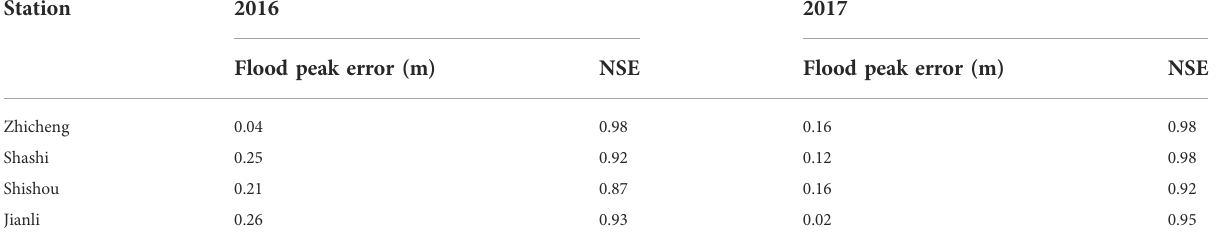
TABLE 1 Simulated results at the main stations in Jingjiang Reach.